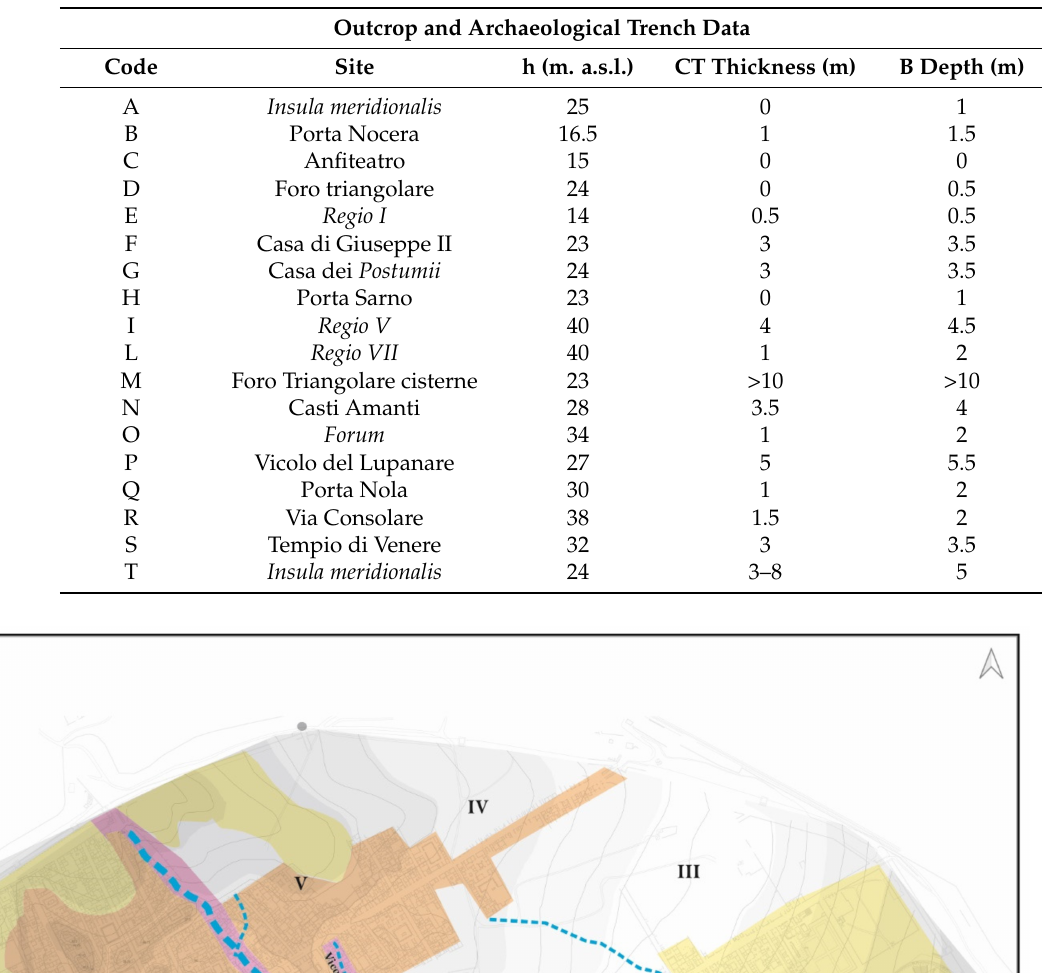
Table 2. Stratigraphical data from outcrops and archaeological excavations with indication of the CT thickness and B depth from the 79 AD ground level.